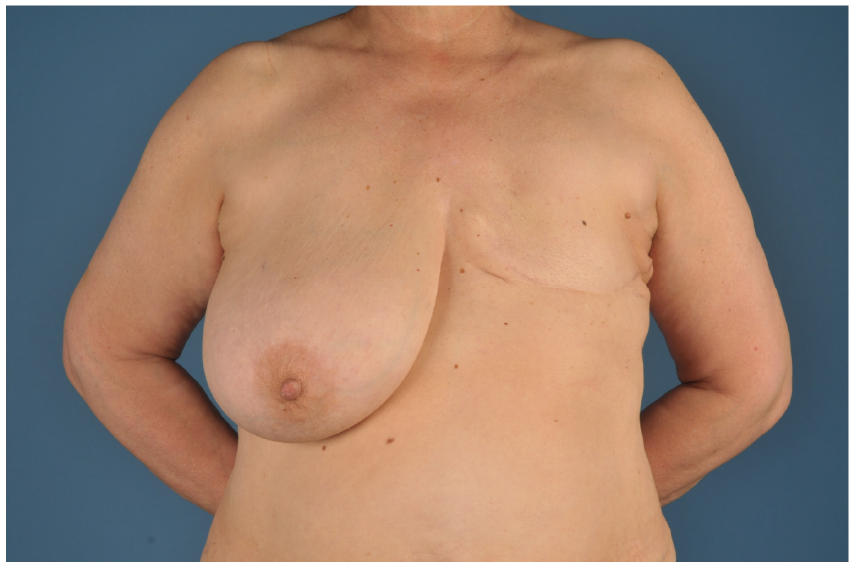
Figure 1. Selection criteria for the split breast technique: unilateral mastectomy defect and a ptotic and hypertrophic healthy donor breast on the contralateral side.